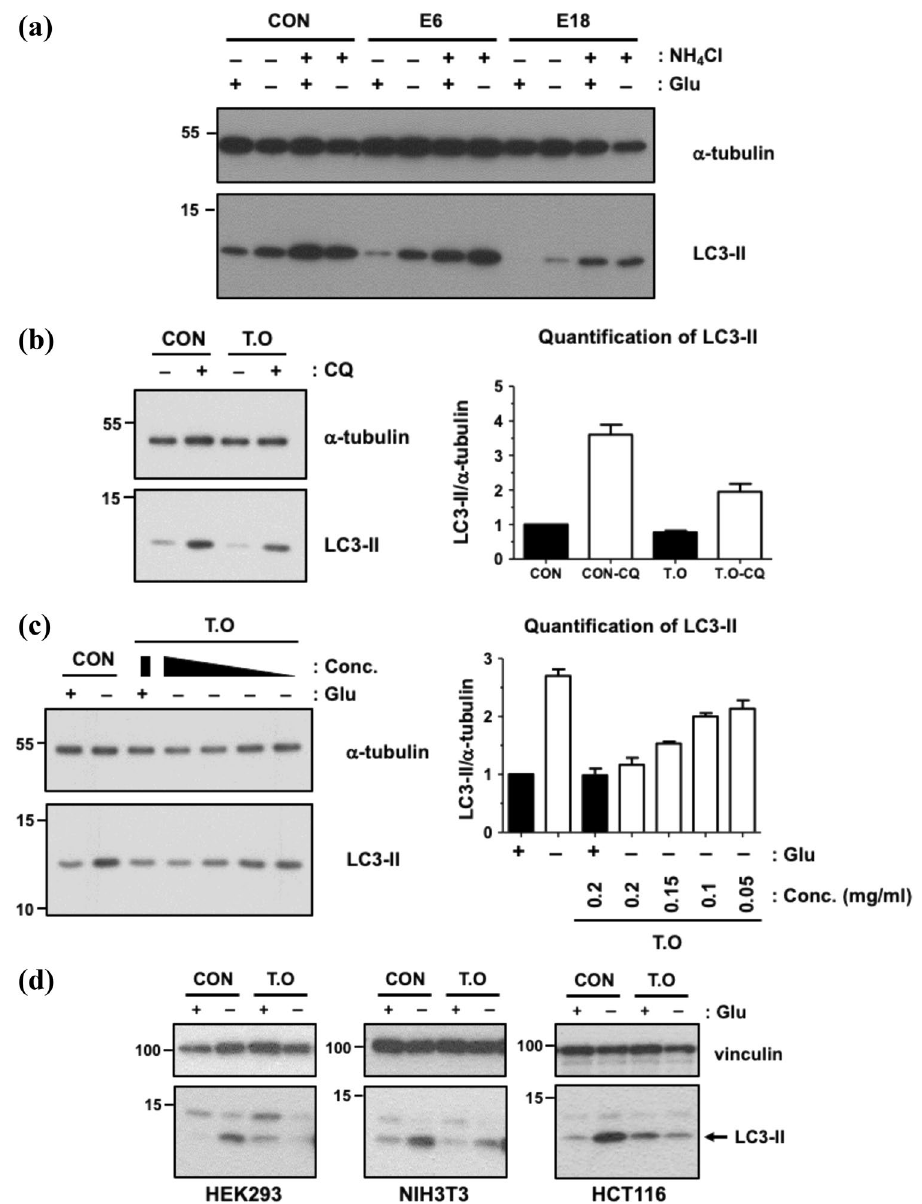
Figure 3. T. orientalis inhibits the starvation-induced autophagy. ( a ) E18 ( Thuja orientalis ) inhibits the starvation-induced autophagy. MEFs were starved for glucose (Glu) overnight in the presence of 0.2 mg/ml of the extracts, in which 10 mM NH 4 Cl was added as indicated. ( b ) Autophagy flux was decreased, but not blocked, by T. orientalis . MEFs were grown in the DMEM culture medium with or without 10 μM Chloroquine (CQ) for 8 h to block lysosome-dependent LC3-II degradation, thereby leading to LC3-II accumulation. To test the effect of T. orientalis (T.O) on the basal autophagy flux, 0.2 mg/ml of T.O was added to examine autophagy as evidenced by LC3-II immunoblot. ( c ) Dose-dependent inhibition of the starvation-induced autophagy by T. orientalis . MEFs were starved for glucose for 8 h, in which the decreasing amount of T.O (0.2, 0.15, 0.1, and 0.05 mg/ml) was added as indicated. ( d ) The starvation-induced autophagy was inhibited by T. orientalis in various cell lines. HEK293, NIH3T3, and HCT116 were starved for glucose overnight in the presence or absence of 0.2 mg/ml T. orientalis as indicated. Quantification of LC3-II level with respect to the level of α-tubulin was obtained by analyzing the intensities of LC3-II and α-tubulin on immunoblots from 3–5 independent experiments, of which one representative image was shown. Image analysis was performed by Image J program. The original unprocessed full-length images of the western blots in this study can be found in Supplemental Fig.